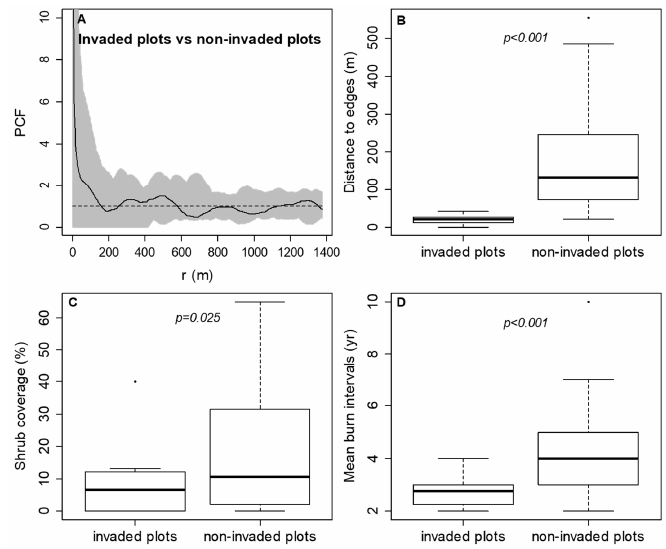
plots at all spatial scales since the PCF curve was within the simulated envelope (the shaded area) (Figure 6A). Based on Hotelling’s T 2 tests, invaded interior plots were significantly different from non-invaded interior plots in terms of distance to nearest edge, understory shrub coverage and mean fire return interval ( p < 0.0001). Invaded plots were located significantly closer to roadways and fire lines with a mean distance of 20.3 m in contrast to 167.6 m for the non-invaded plots ( p < 0.001, Figure 6B), and had lower shrub coverage (8.57 ± 3.23% vs. 18.42 ± 2.60%) ( p = 0.025, Figure 6C) and shorter Figure 5. Change of tallow seedling ( ≤ 2 years) densities by risk factors: ( A ) Distance to seed sources; ( B ) year since last fire; ( C ) overstory tree basal area; and ( D ) understory shrub coverage.